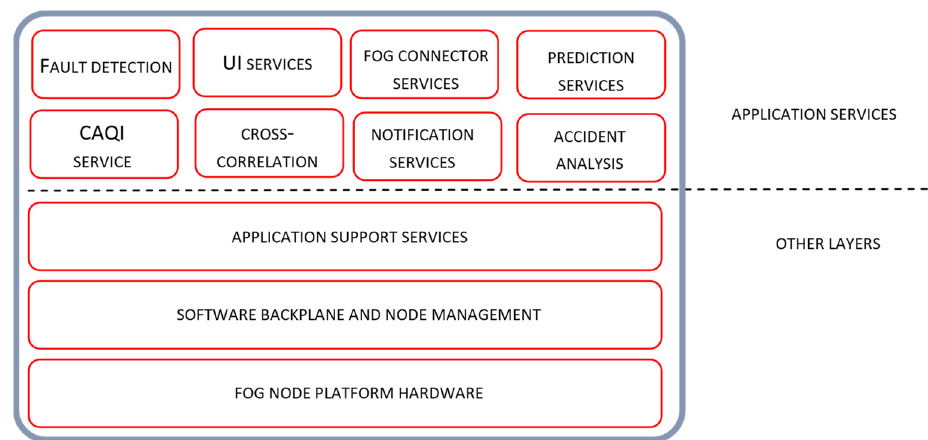
Figure 4. Tier 2 fog node software architecture view.